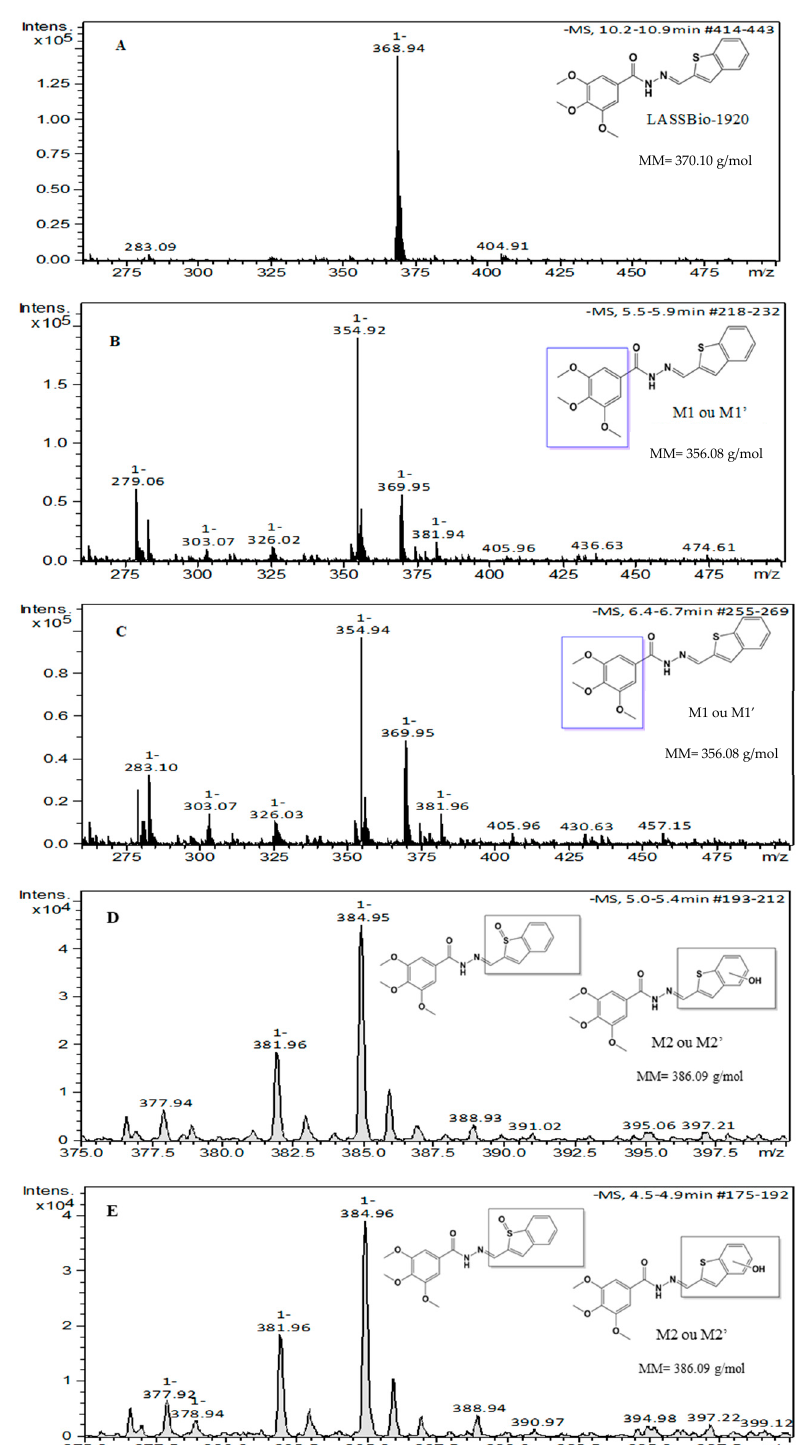
Figure 12. Mass spectrum (HPLC/MS) of LASSBio-1920 and its metabolites. ( A ) LASSBio-1920, 369 m / z (M–H); ( B , C ) Metabolites M1 or M1 ′ , 355 m / z (M–H), compatible with the O-demethylation process that may occur at the 3, 4 or 5 of trimethoxybenzyl moiety; ( D , E ) metabolite M2 or M2 ′ , 386 m / z (M–H), compatible with S-oxidation process and/or some hydroxylation in the benzothiophene ring.